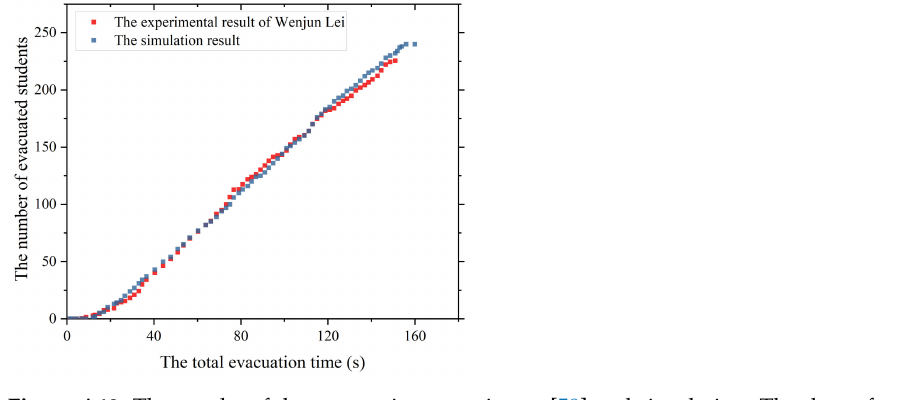
Figure A12. The results of the evacuation experiment [59] and simulation. The data of evacuation experiment is adapted with permission from Ref. [59]. Copyright 2012 Elesvier. Table A1. The comparison result between the evacuation experiment and simulation.